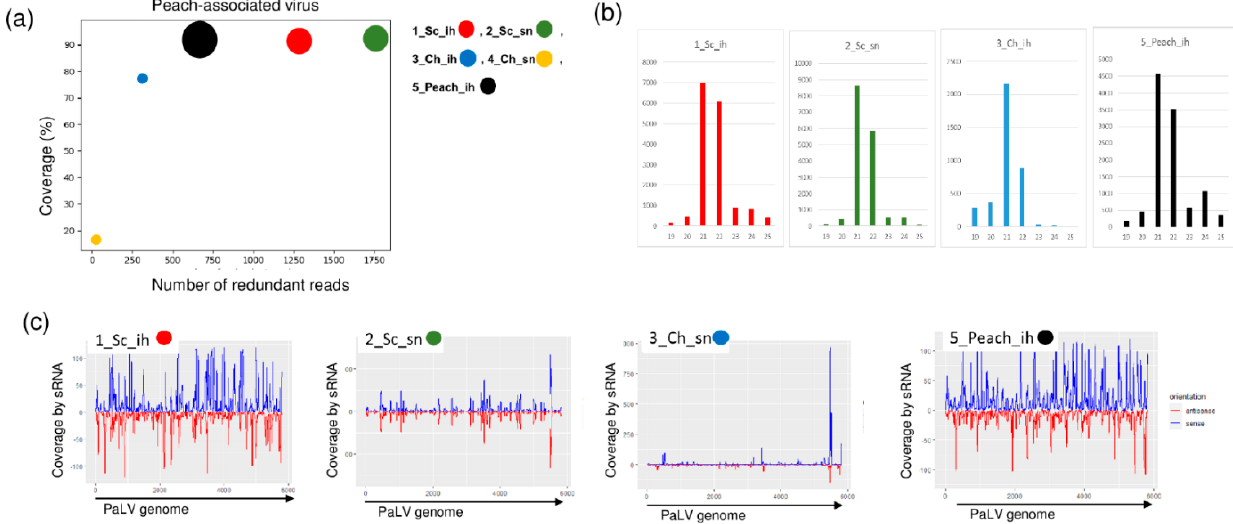
Figure 5. The result of the sRNA HTS and its validation for PaLV in the five sRNA libraries. ( a ) The graphic representation of the result of the bioinformatics analysis of sRNA HTS. The coverage of the PaLV genome ( y -axis) together with the number of RPM (number of PaLV-specific non-redundant reads in 1 million sequenced reads on the x -axis) was plotted as a circle whose diameter is proportional to the number of contigs. Different colors were used for the five libraries, as indicated. ( b ) The size class distribution of the PaLV-derived reads in the 1_Sc_ih, 2_Sc_sn, 3_Ch_ih and 5_Peach_ih libraries ( c ) PaLV-derived reads in the 1_Sc_ih, 2_Sc_sn, 3_Ch_ih and 5_Peach_ih libraries are shown as they mapped to the PaLV genome, indicating their sense and antisense origin (Sc: Springcrest; Ch: Cresthaven; ih: isolator house; sn: stock